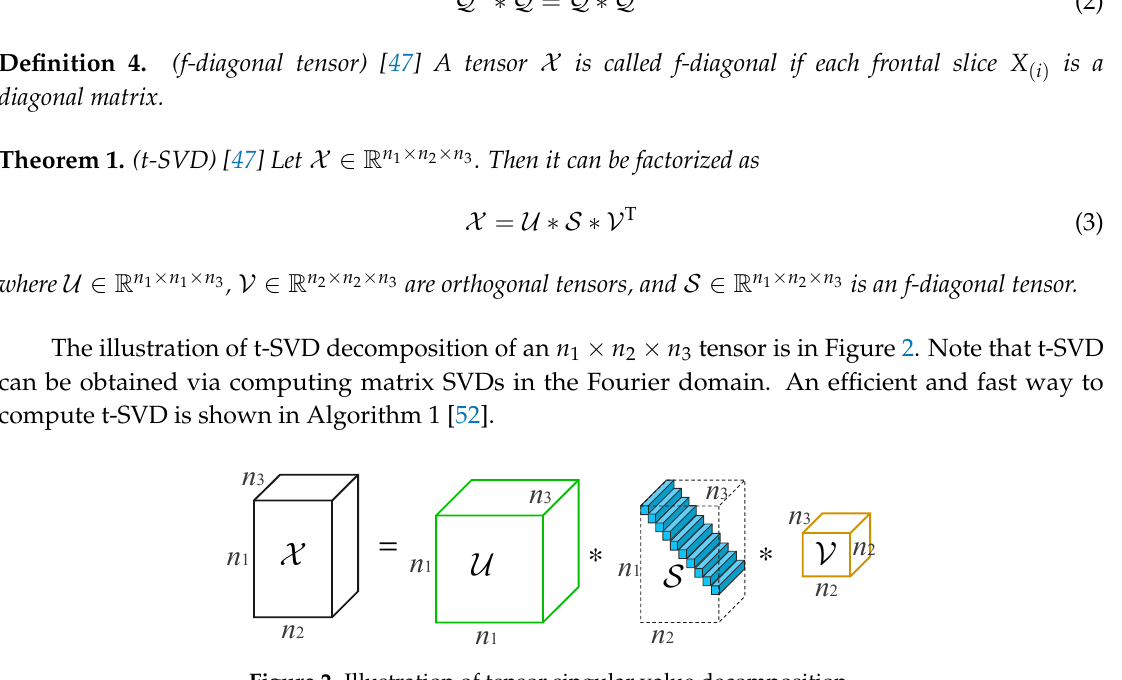
Figure 2. Illustration of tensor singular value decomposition. Algorithm 1 T-SVD for three-order tensors